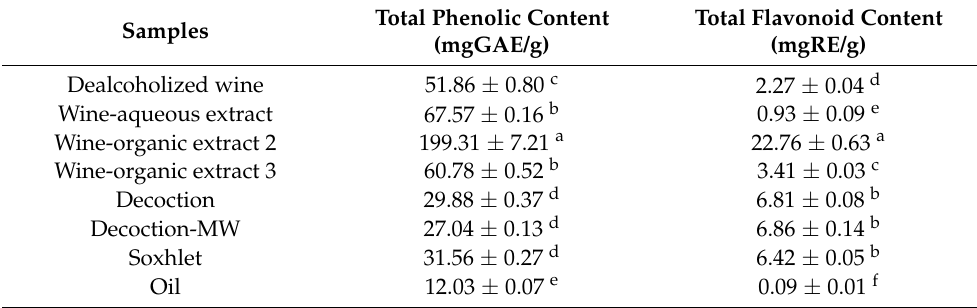
Table 2. Total phenolic, flavonoid contents of the tested